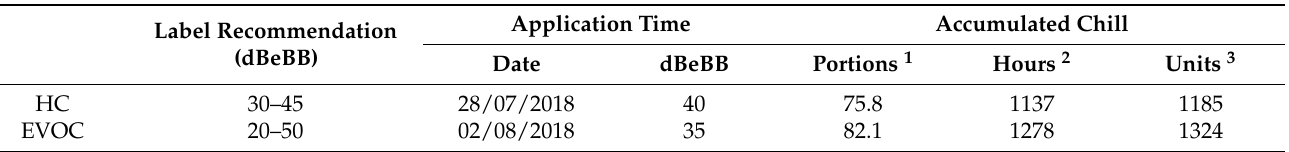
Table 1. Chemical application dates and accumulated chill. dBeBB = days before estimated bud burst; HC = Dormex ® ; EVOC = Waiken ®